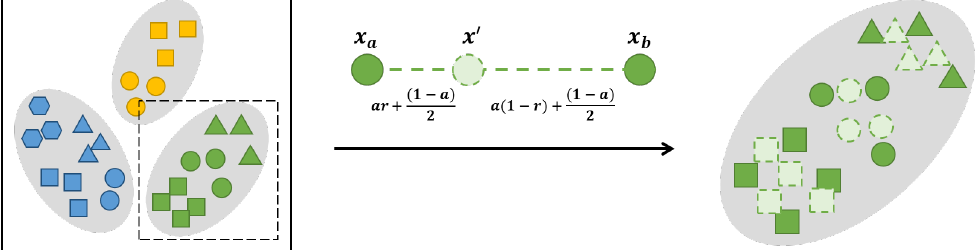
Figure 4. Intra-cluster synthesis. We select similar samples in batches, divide them by the clusters obtained from the initialization module, and use the strategy of intra-cluster synthesis, which is performed with a controllable degree of randomness. The distribution of samples before synthesis is shown in the left figure, where each color represents a class of sample features and different shapes indicate different clusters. The middle image represents our proposed synthesis method with random factor, where x (cid:48) is the sample synthesized through samples x a and x b , and the right image shows the distribution of the samples synthesized by the green class, and we use the dashed edges to indicate the synthesized